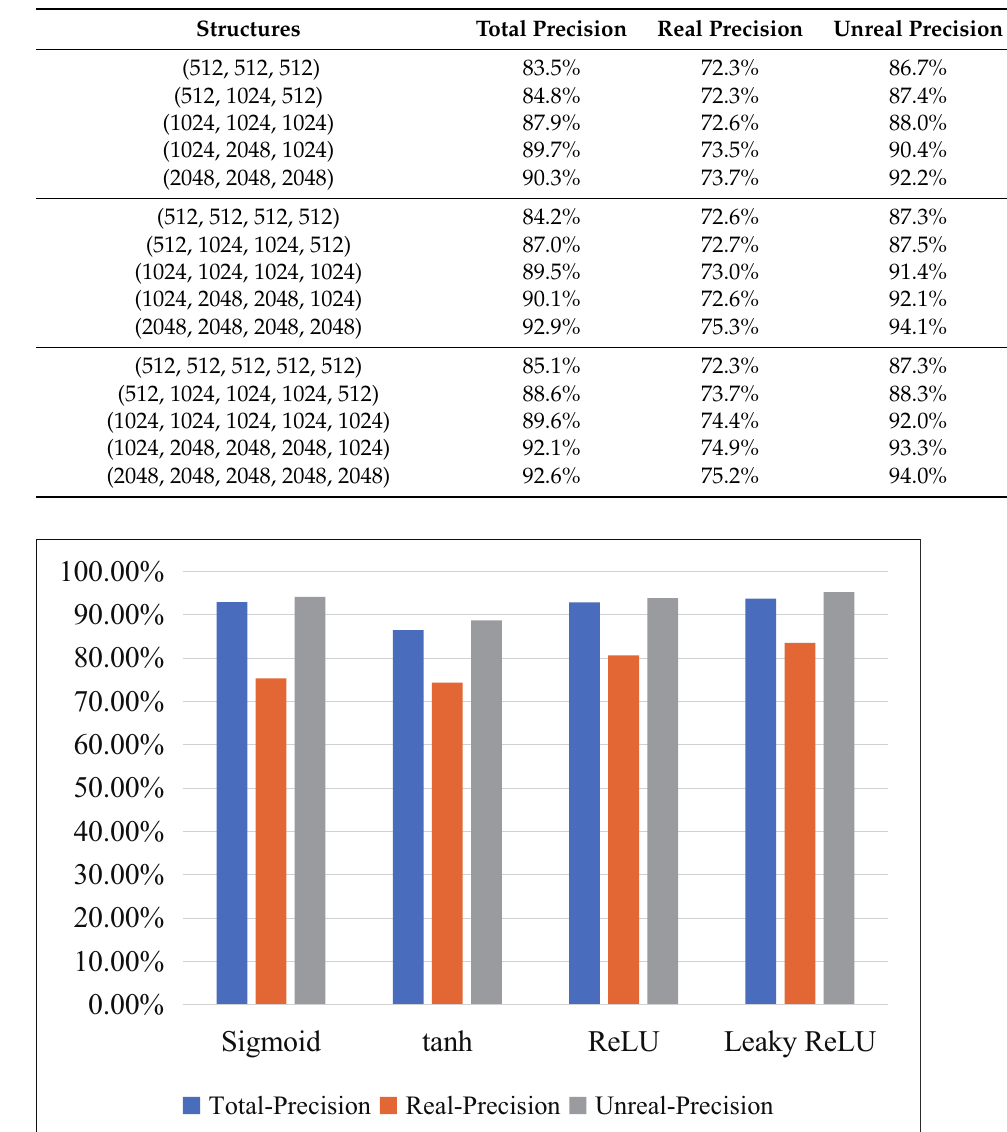
Figure 10. Comparison of experimental results with different activation